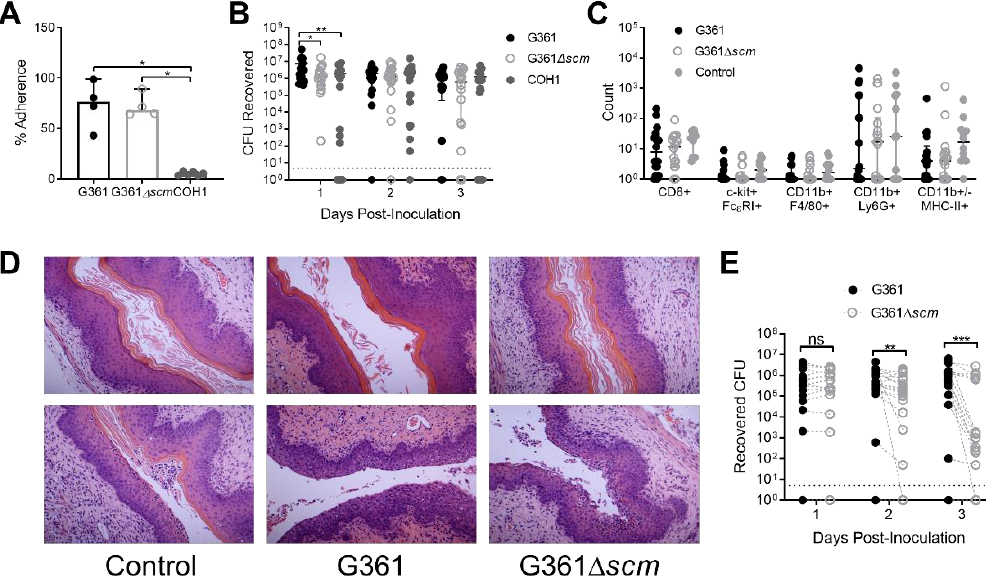
Figure 4. S. canis adheres to vaginal epithelial cells and persists in a murine model of vaginal colonization, and SCM confers a fitness advantage in this environment. ( A ) Percent adherence of S. canis G361, G361 ∆ scm , or GBS COH1 to VK2 cells after 30 min of infection, MOI = 1. CD1 female mice were vaginally administered 1 × 10 7 CFU of WT S. canis G361, G361 ∆ scm , or WT GBS COH1, or PBS as a control. ( B ) Mice were vaginally swabbed daily, and the levels of bacterial CFU recovered from swabs are shown. ( C ) Cells collected from day 3 post-inoculation were analyzed for surface markers via flow cytometry. Total cell counts of each population recovered on the swabs are shown. ( D ) Vaginal epithelial tissues were fixed, sectioned, and stained with H&E. Histological examination revealed keratinized epithelium (top images) and neutrophil infiltration (bottom images) similarly across treatment groups. Magnification = 200X. ( E ) CD1 female mice were vaginally administered 1 × 10 7 CFU each of WT S. canis G361 and G361 ∆ scm in competition. Mice were vaginally swabbed daily, and the levels of bacterial CFU recovered from swabs are shown. Symbols represent biological replicates (( B ), n = 18/group, ( C ), n = 12–18/group, and ( E ), n = 20/group) or the means of four independent experimental replicates ( B ), performed in technical duplicate) with lines indicating medians and interquartile ranges. Dotted line in ( B , E ) indicates limit of detection. Data were analyzed by Kruskal-Wallis test with Dunn’s multiple comparisons test ( A ), two-way ANOVA with Sidak’s multiple comparisons post-test ( B , C ) or Wilcoxon matched-pairs signed rank test ( E ). ***, p <0.001; **, p <0.01; *, p <0.05; ns, not significant.